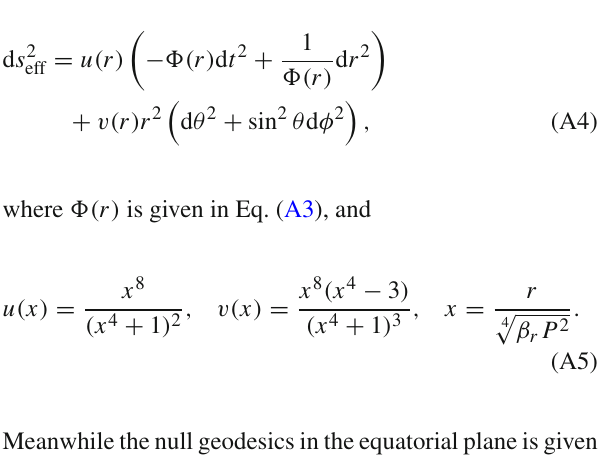
Fig. 18 Observational appearances of regular BH in rational NLED with different magnetic charge and rational NLED’s effects